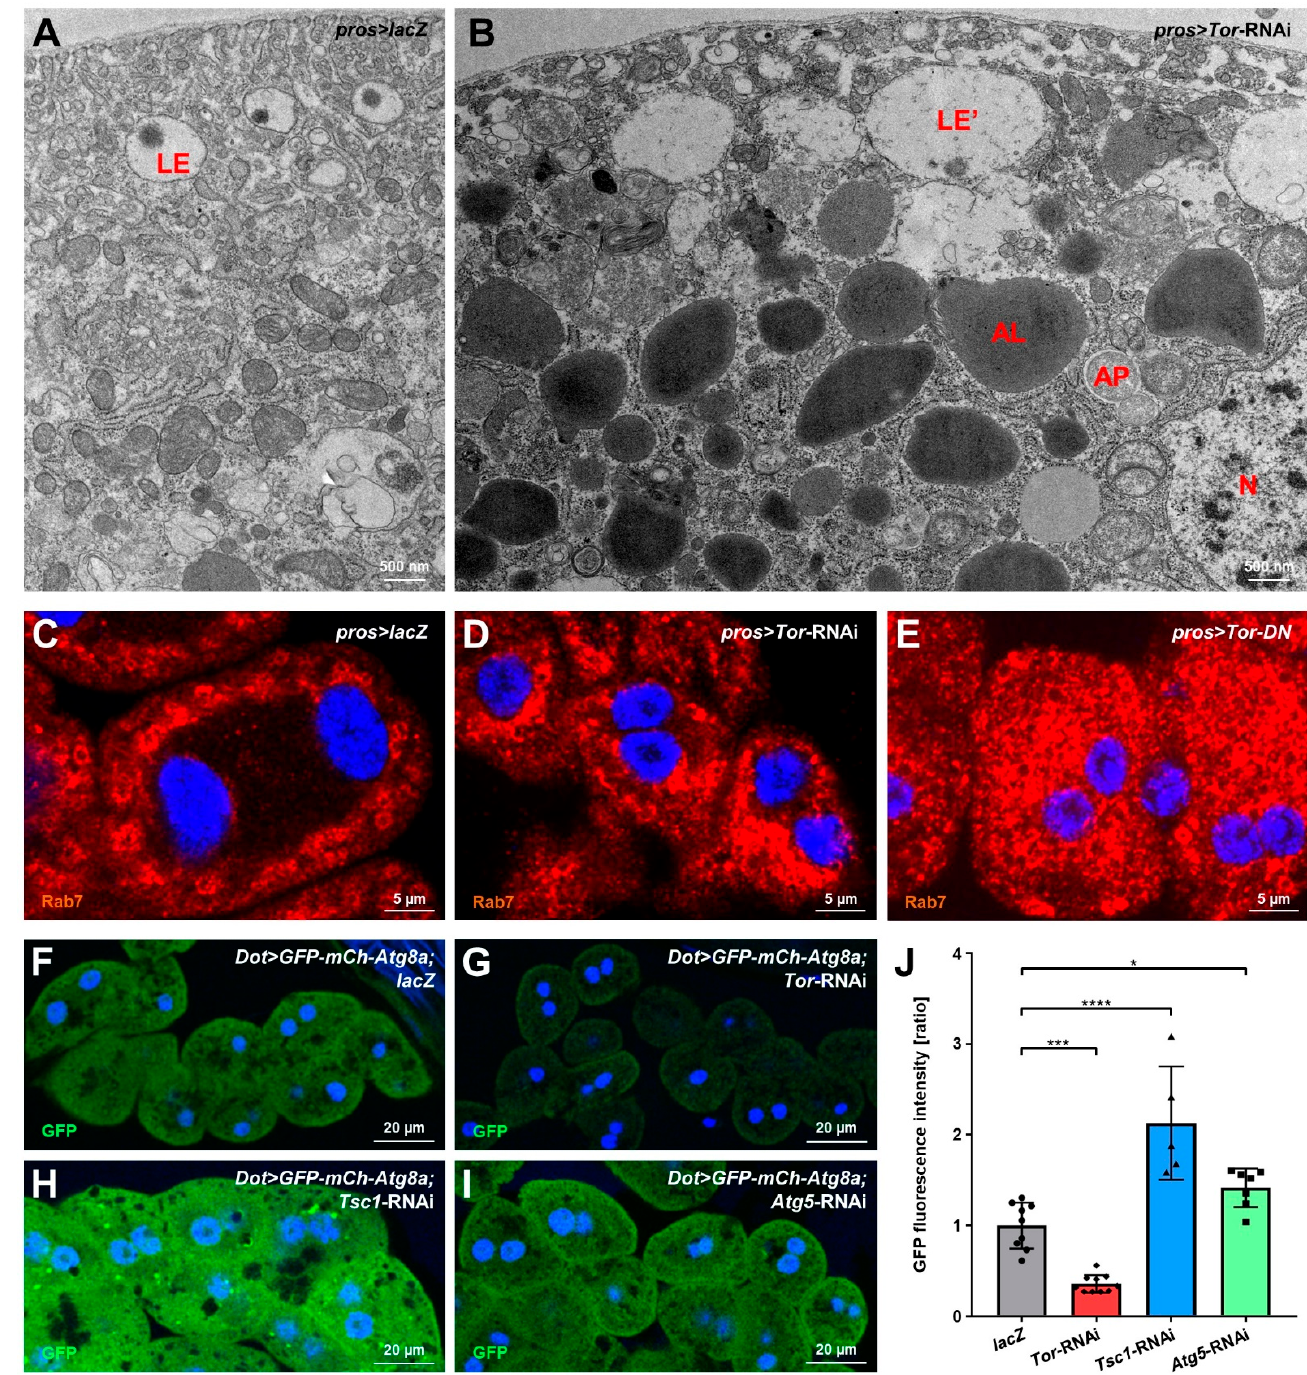
Figure 4. mTOR inhibition in nephrocytes enhances autophagy. ( A – B ) Transmission electron mi- croscopy (TEM) images of cells expressing lacZ ( A ), or Tor -RNAi ( B ). Upon expression of Tor -RNAi under the control of pros-GAL4 , autophagosomes, autophagolysosomes, and various other autophagic vesicles become more numerous. AL: autophagolysosome; AP: autophagosome; LE: late endosome; LE’: aberrant late endosome; N: nucleus. ( C – E ) Nephrocytes were stained for Rab7 to visualize the late endosomal compartment. Expression of Tor -RNAi ( D ) or a dominant-negative var- iant of Tor ( Tor-DN , E ) results in a strong expansion and accumulation of Rab7-positive vesicles compared to lacZ expressing control cells ( C ). Nuclei are stained by Hoechst 33342 in blue here and throughout the figure. ( F – I ) Fluorescence-tagged Atg8a labels various stages of autophagy, thereby serving as a marker for autophagic activity. Co-expression of tagged Atg8a and Tor -RNAi ( G ) under control of Dot-GAL4 results in decreased GFP-derived fluorescence intensity compared to control